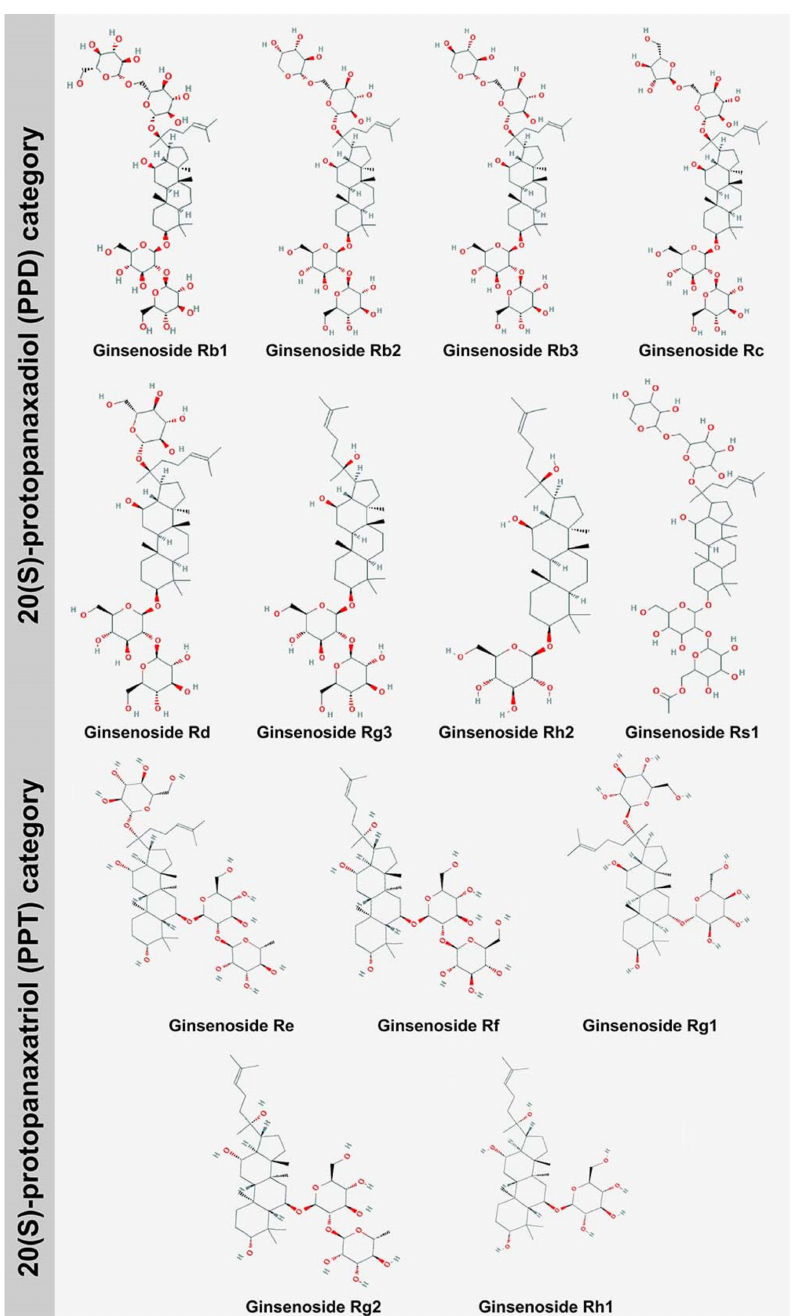
Figure 1. Major structures of ginsenosides belonging to the 20(S)-protopanaxadiol (PPD) and 20(S)-protopanaxatriol (PPT) categories (Structure source: PubChem https: //